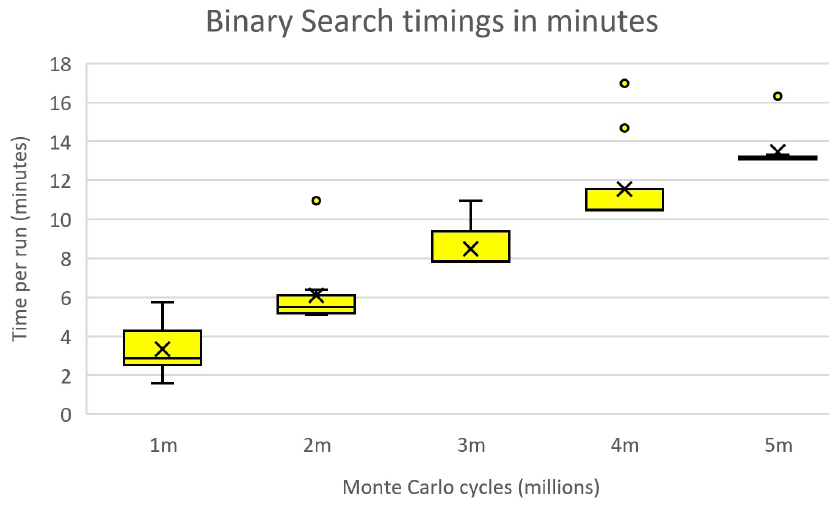
Figure 4. Box plot timings for Binary Search optimisation: 10 runs in each case.